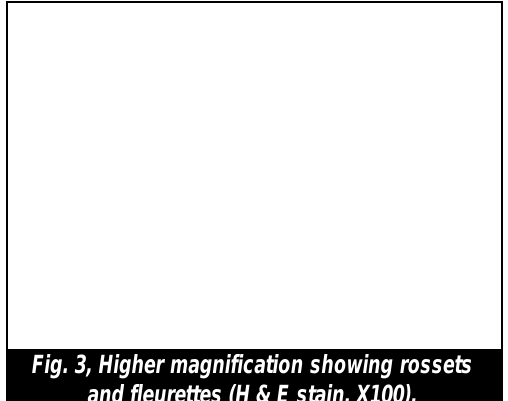
Fig. 3, Higher magnification showing rossets and fleurettes (H & E stain,